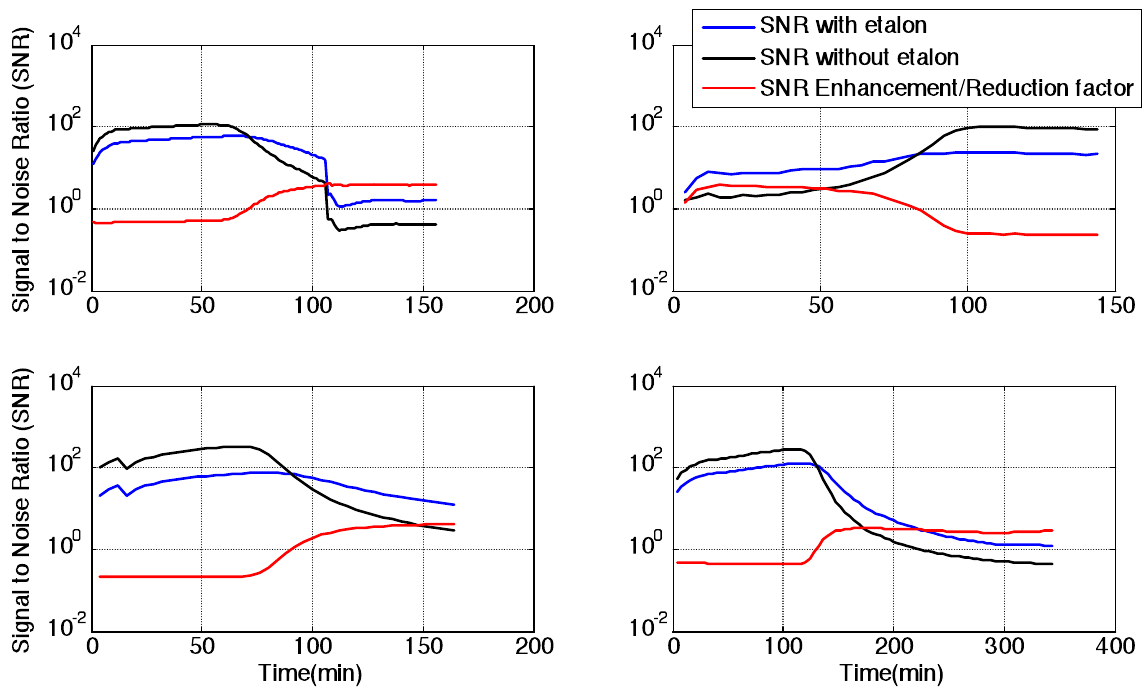
Figure 5. Lidar SNR and SNR enhancement/reduction factors obtained at an altitude of 10 km on different days. Observation times: (a) 0505 to 0740 LT; (b) 1708 to 1930 LT; (c) 0510 to 0754 LT; (d) 0415 to 1003 LT. Sun positions at pointer: (a) 0610 LT, SZA ( } ) 93˚; (b)1840 LT, SZA( } ) 95˚; (c) 0610 LT, SZA ( } ) 92˚; (d) 0615 LT, SZA ( } )